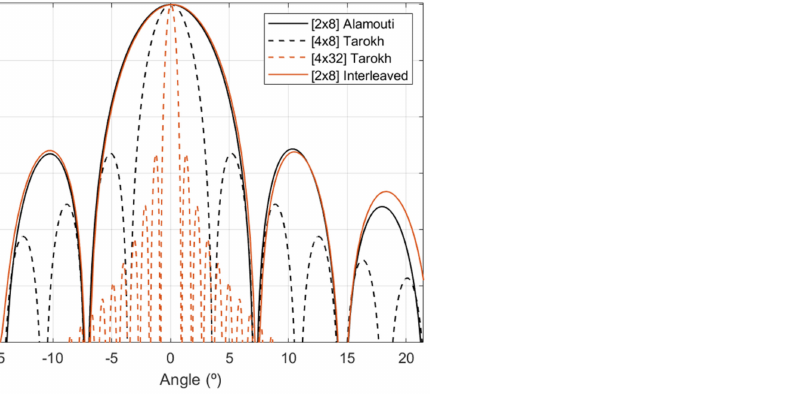
Figure 7. Direction-finding resolution comparison between SFBCs schemes and interleaved approach for a target located at 0 ◦ .